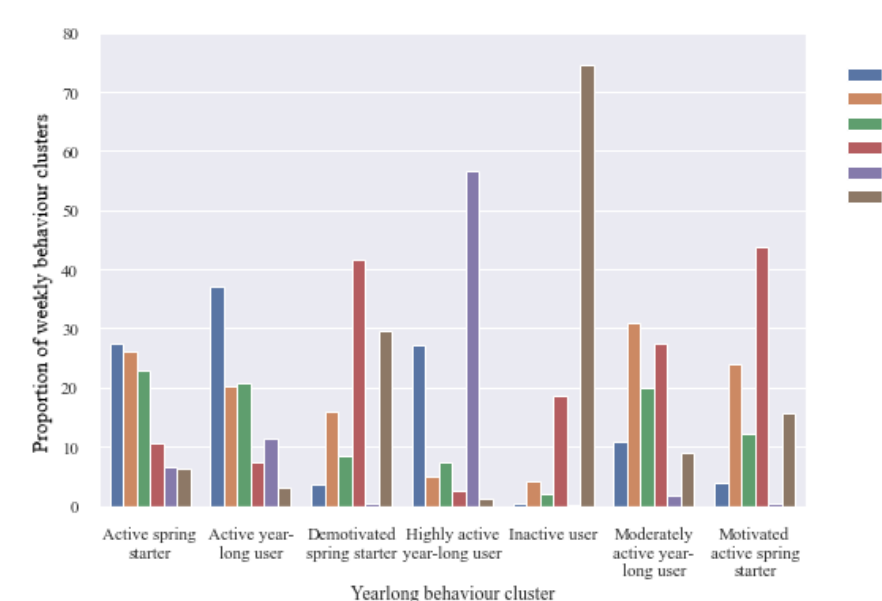
Figure 12. Proportion of user’s weekly physical activitybehaviour clusters contributing to their annual physical activity behaviour